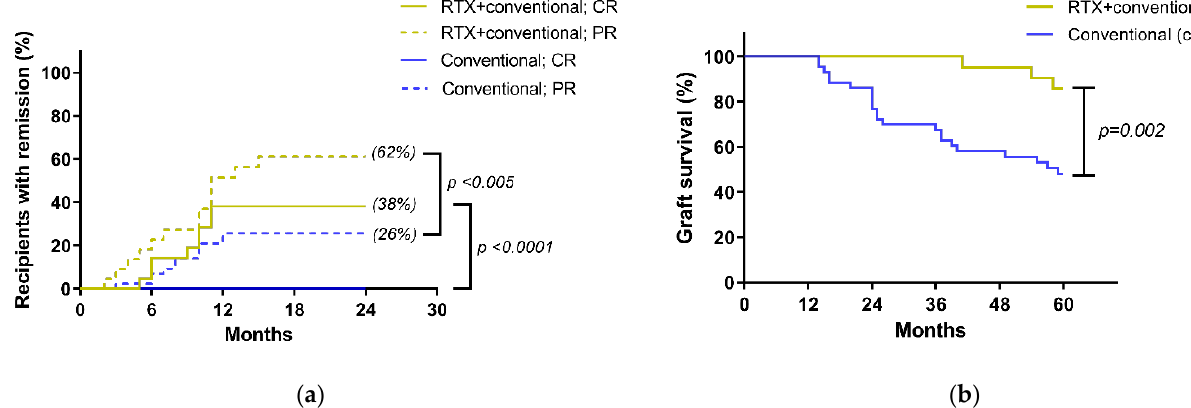
Figure 3. Treatment outcomes: ( a ) the percentages of recipients in each of the 4 subgroups according to the treatment response indicated as complete remission (CR) or partial response (PR) (see Method); ( b ) Kaplan–Meier estimates of renal allograft survival in recipients correspond to treatment group; RTX, rituximab.